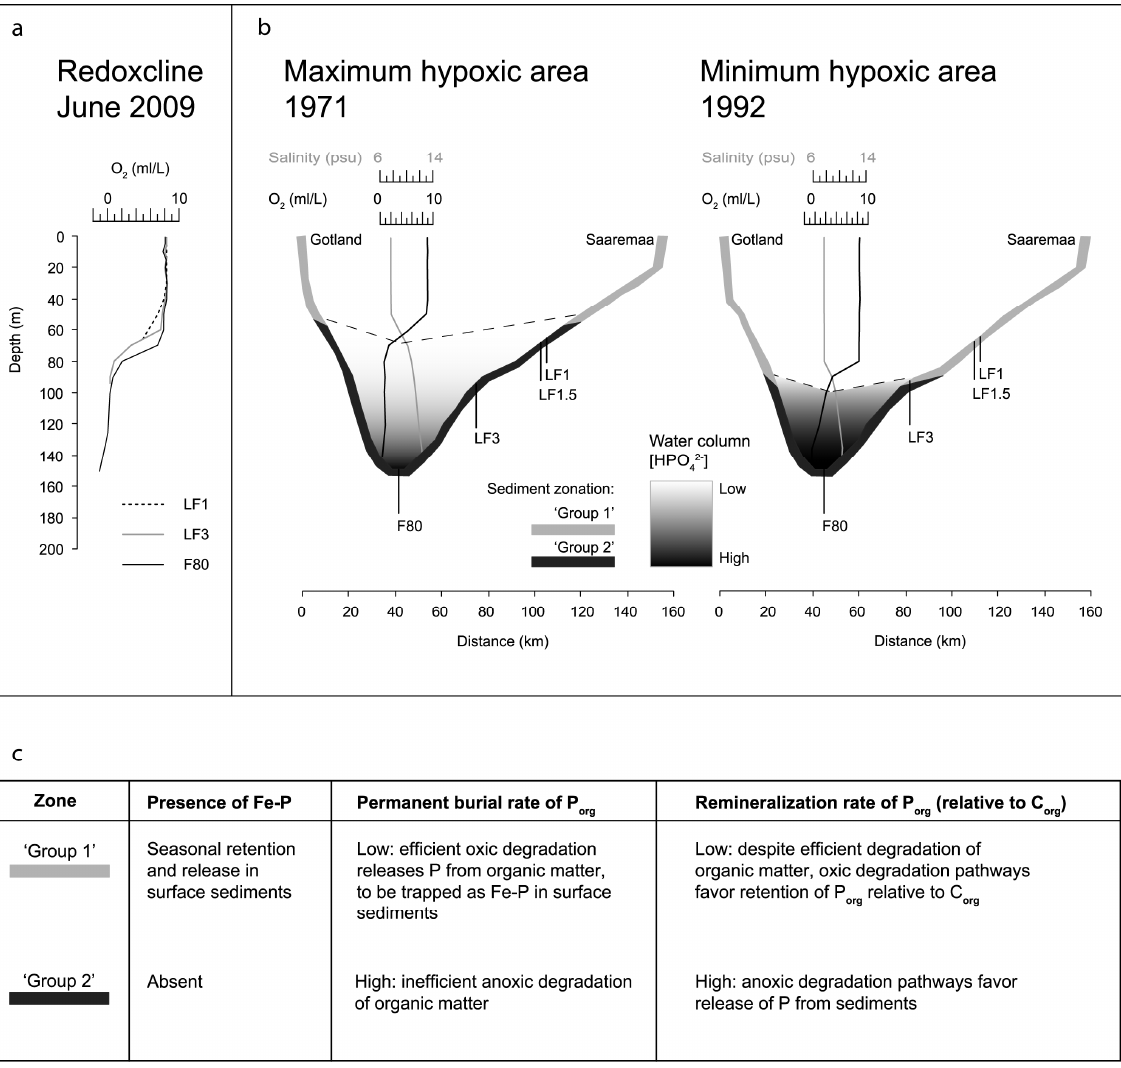
Fig. 8. (a) Water column oxygen concentrations measured during the R/V Aranda cruise of May/June 2009 at sites LF1, LF3 and F80 along a depth transect into the F˚ar¨o Deep between the islands of Gotland and Saaremaa, showing the vertical offset of the redoxcline between central (F80) and marginal (LF1) sites. (b) Scaled cross-sectional sketches through F˚ar¨o Deep in 1971 and 1992 (simplified bathymetry from Data Assimilation System of Baltic Environmental Database, Stockholm University, depth scale as for (a) ), showing water column salinity and oxygen profiles from F80 (also known as BY20, data from Baltic Environmental Database) in the month of February (chosen for comparable data availability). With the exception of F80, sites are positioned accurately by depth. The simplified bathymetry aliases the true depth of F80 (191m, Fig. 2) and generates minor lateral offsets from true position of all sites. Dashed lines show approximate position of hypoxia threshold (O 2 = 2mlL − 1 ) based on profiles at F80 and assumption of 15m vertical offset of redoxcline between F80 and LF1 (see (a) ). Shading in water column below halo/redoxcline qualitatively represents deep water [HPO 2 − on the assumption that iron oxyhydroxides are absent from surface sediments below a threshold of oxygen stress which may be spatially variable but generally deeper than that of bottom water hypoxia. (c) Table summarizing characteristics of sediment zones with respect to the phosphorus